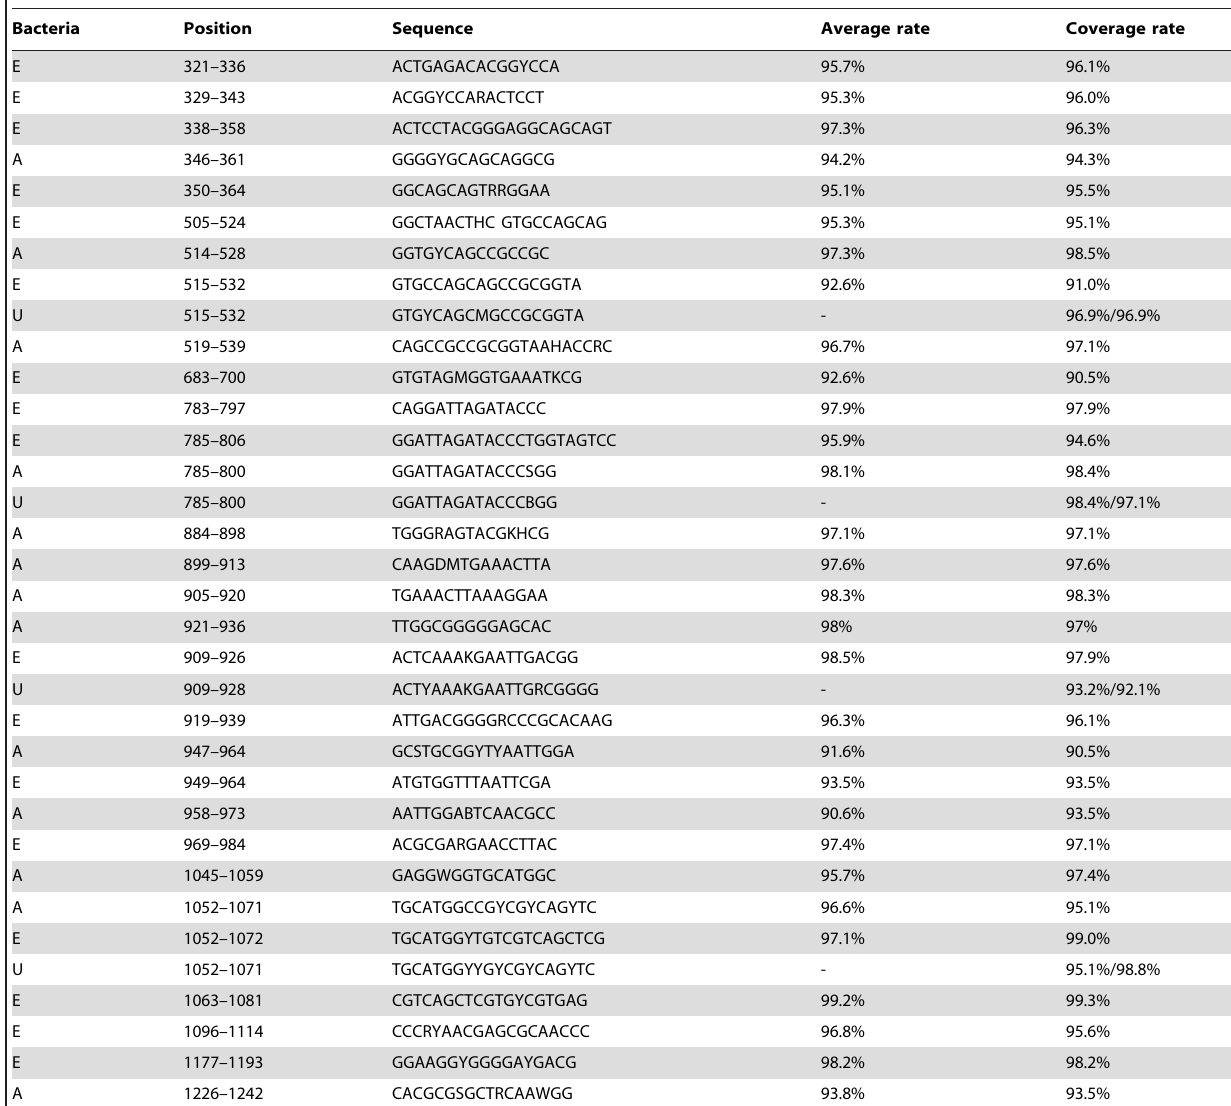
Table 2. The coverage rate of predicted